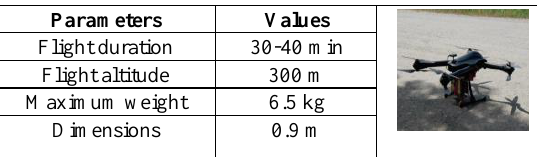
Table 3. UAV technical